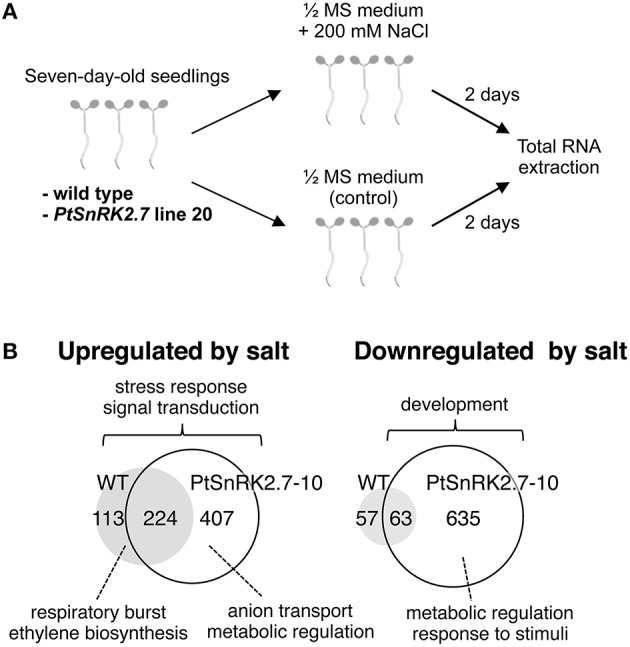
Microarray analysis of the wild-type and PtSnRK2.7 overexpressor line 20. (A) Overview of sample preparation for microarray analysis. (B) Venn diagram of upregulated and downregulated genes after salt stress treatment in the wild-type and PtSnRK2.7 overexpressor.